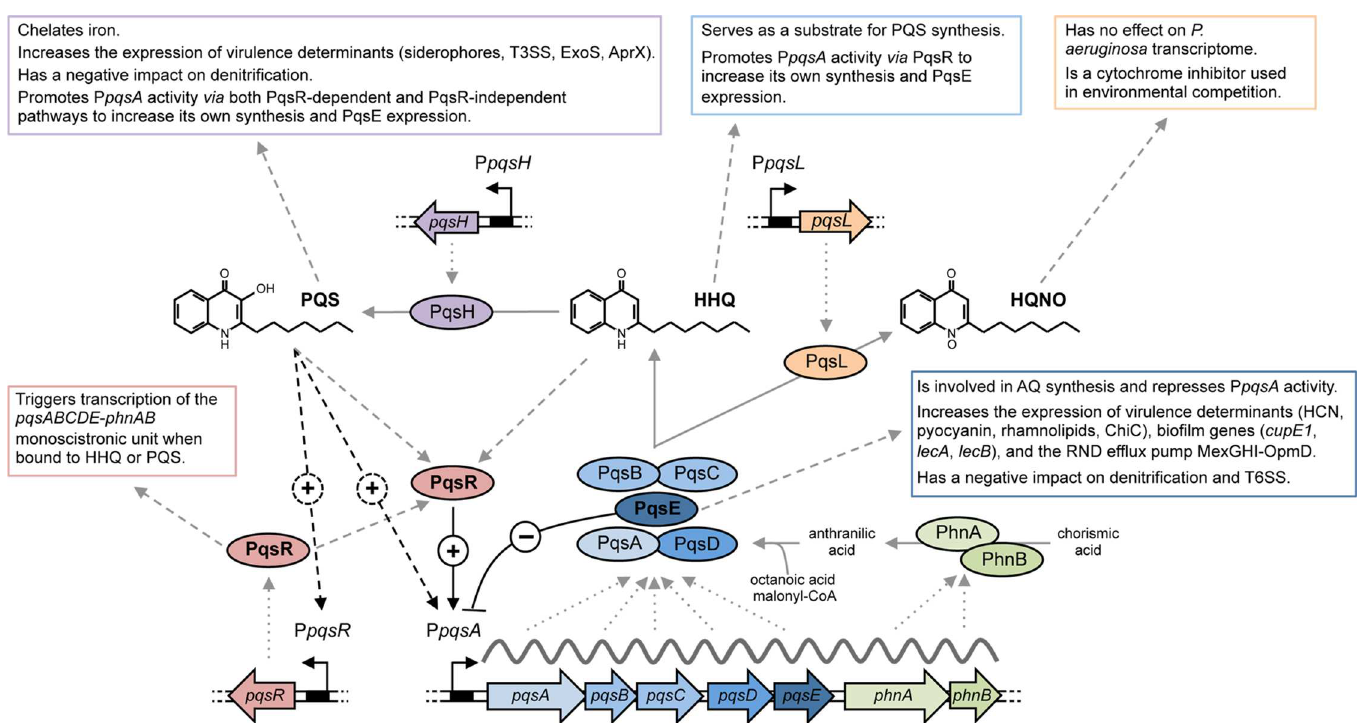
Fig 7. Schematic representation of the pqs QS system in P . aeruginosa . The core of the pqs QS system is composedof the pqsABCDE-phnAB operon and the pqsR gene. Proteins coded by the pqsABCDE-phnAB operon synthesize HHQ that binds to and activates PqsR. The PqsR-HHQ complex promotes P pqsA activity, thus increasingHHQ and PqsE levels. Notably, the P pqsA promoter is the only target of the PqsR-HHQ complex. Apart from its contribution to HHQ biosynthesis, PqsE influencesthe P . aeruginosa transcriptome via a still uncharacterized AQ-independent pathway(s). In this way, PqsE up- regulates the expression of genes involvedin virulencefactor production, biofilm development, and antibiotic resistance. Conversely, PqsE down-regulates P pqsA activity, AQ productionand the expressionof genes involvedin denitrification and T6SS. The pqsH and pqsL genes are requiredfor PQS and HQNO biosynthesis, respectively. HQNO did not affect the P . aeruginosa transcriptome, and probablycontributes to environmental competition due to its cytochrome inhibitoryactivity. PQS chelates iron triggeringthe iron-starvation response and increasingthe transcription of virulencefactor genes coding for virulencefactors such as pyoverdine, ExoS toxin and AprX protease. Moreover, PQS down-regulates genes involvedin denitrification. Most of the regulatory effects exerted by PQS are PqsR-independent, since the PqsR-PQS (or PqsR-HHQ) complex only promotes P pqsA activity. However, PQS also increases P pqsA and P pqsR expression via a PqsR-independent pathway(s) that is unrelated to the iron-starvation response, but is inhibitedin the presence of high- iron concentrations. Dotted grey arrows indicate gene expression; solid grey arrows represent biosynthesis; solid black arrow indicatesPqsR-dependent activation (+); dashed black arrows indicate PqsR-independent activation (+); black T-line indicates negative regulation (-); dashed grey arrows represent information